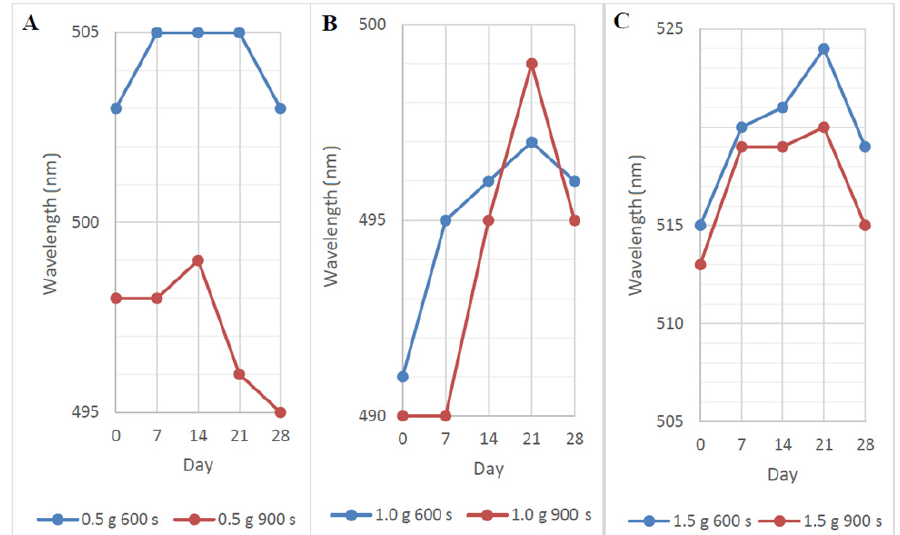
Figure 6. AuNP absorption peak positions in PEG/NALC/H 2 O prepared with a deposition time of 600 or 900 s in NALC/H 2 O: ( A ) 0.5 g/100 mL, ( B ) 1.0 g/100 mL, and ( C ) 1.5 g/100 mL.